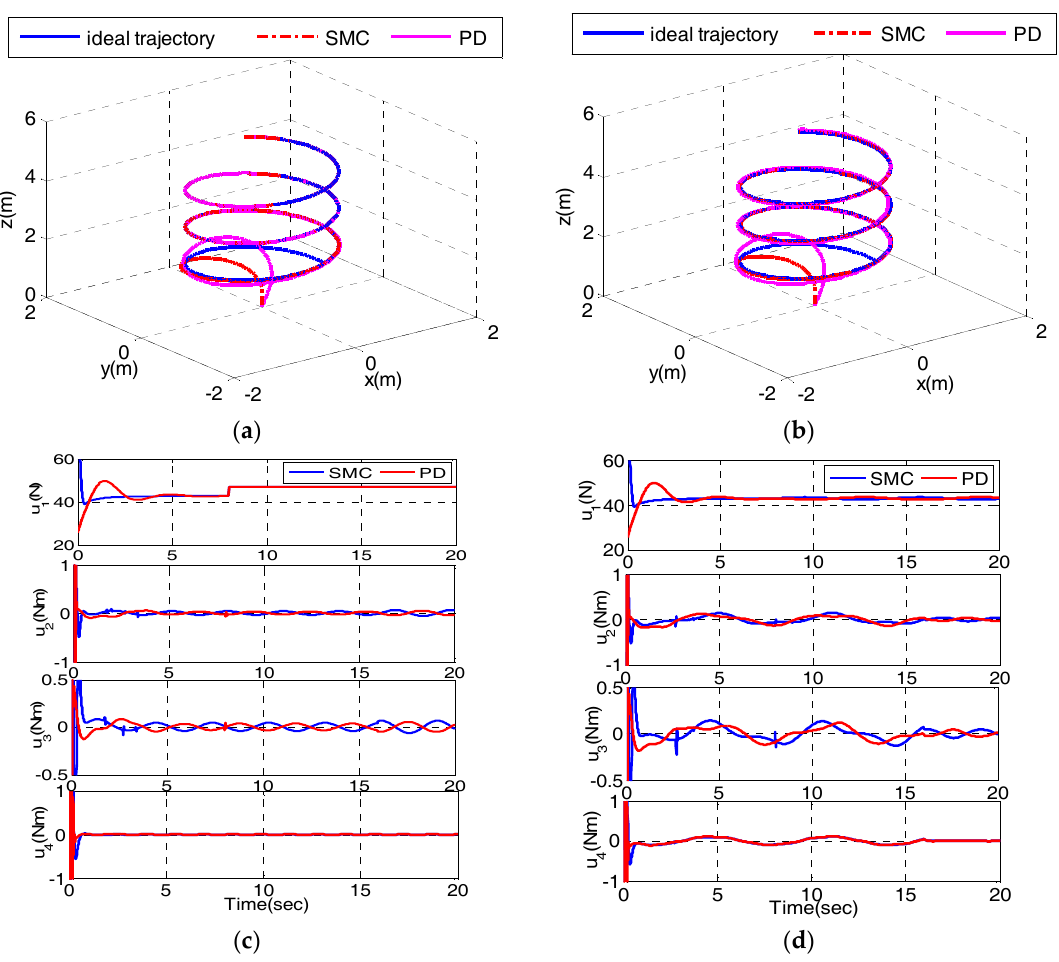
Figure 7. Comparisons under both controllers for trajectory tracking simulation in two cases ( a ) The trajectory in Case 1; ( b ) The trajectory in Case 2; ( c ) The control inputs in Case 1; ( d ) The control inputs in Case 2.